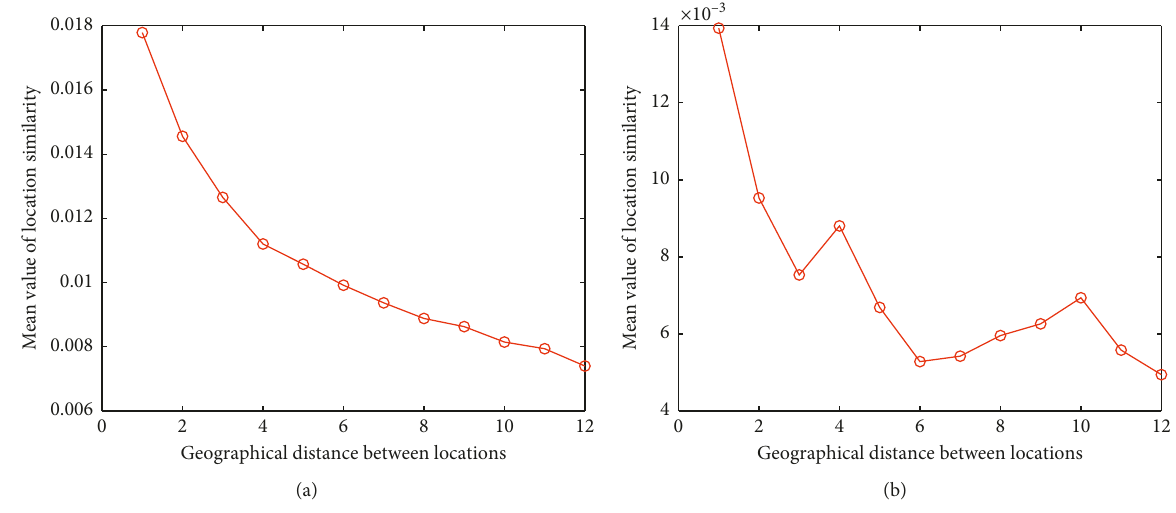
Figure 4: Density estimation of users’ similarity on (a) Gowalla and (b)